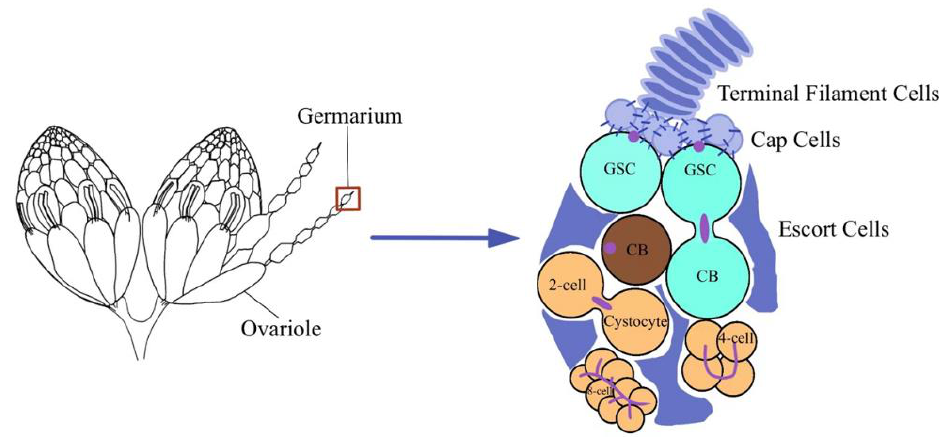
Figure 1. Different types of somatic and germ cells in the germarium of Drosophila. The ovary of Drosophila consists of 16–20 ovarioles, and the anterior region of each ovariole is known as germarium. Germarium houses different types of somatic cells (terminal filaments, cap cells, and escort cells). These somatic cells are vital for the maintenance of germ cells (germline stem cells, cystoblasts). In addition, GSCs are anchored with the cap cells which help them to retain their stem cell character. Further, the GSCs are directly connected with the escort cells which are also necessary for their proper maintenance.